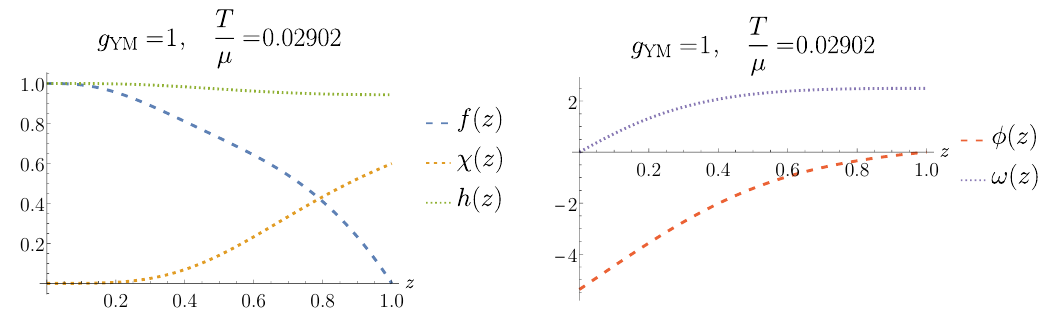
Figure 2. Plots of the matter and metric functions, for T/µ = 0 . 02902 and g YM = 1 . As shown, the function behaviour away from critical temperature (and within superconducting phase) is far more complicated. This is especially visible in the non-constant h ( z ) and χ ( z ) and also in the larger value of ω ( z ) throughout the